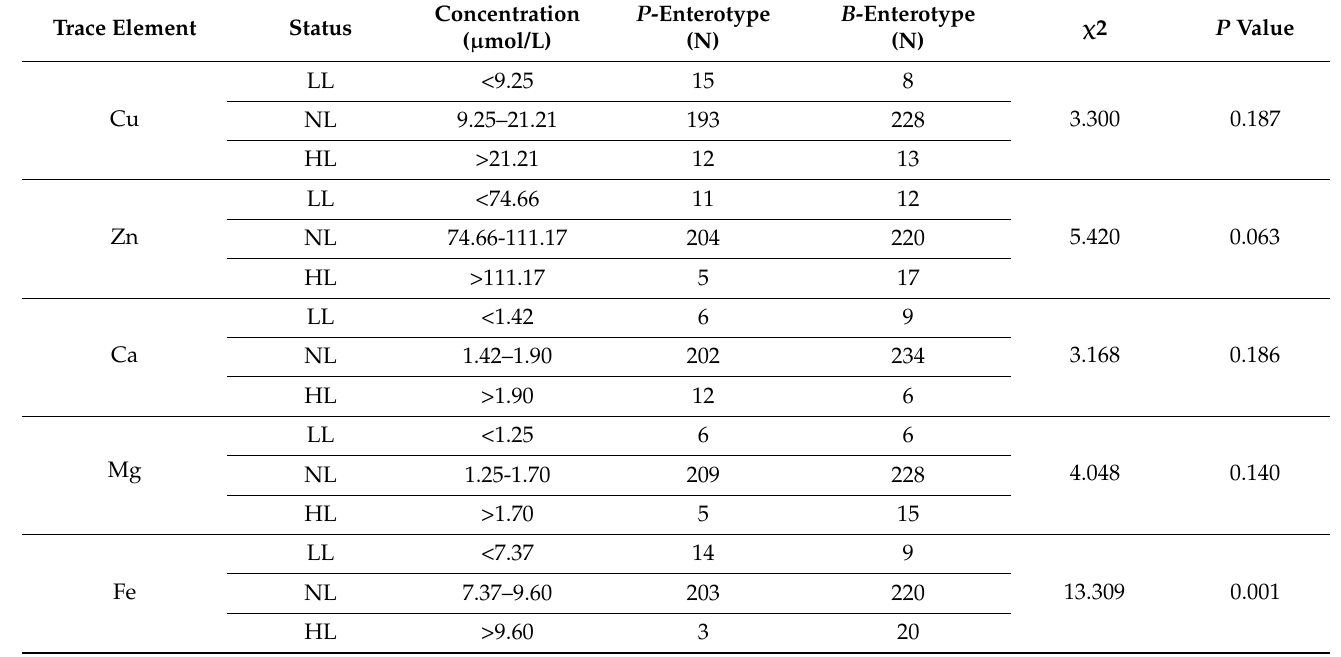
Table 3. Comparison of Prevotella -enterotype and Bacteroides -enterotype in the LL, NL, and HL of the five whole blood trace elements among infertile group.